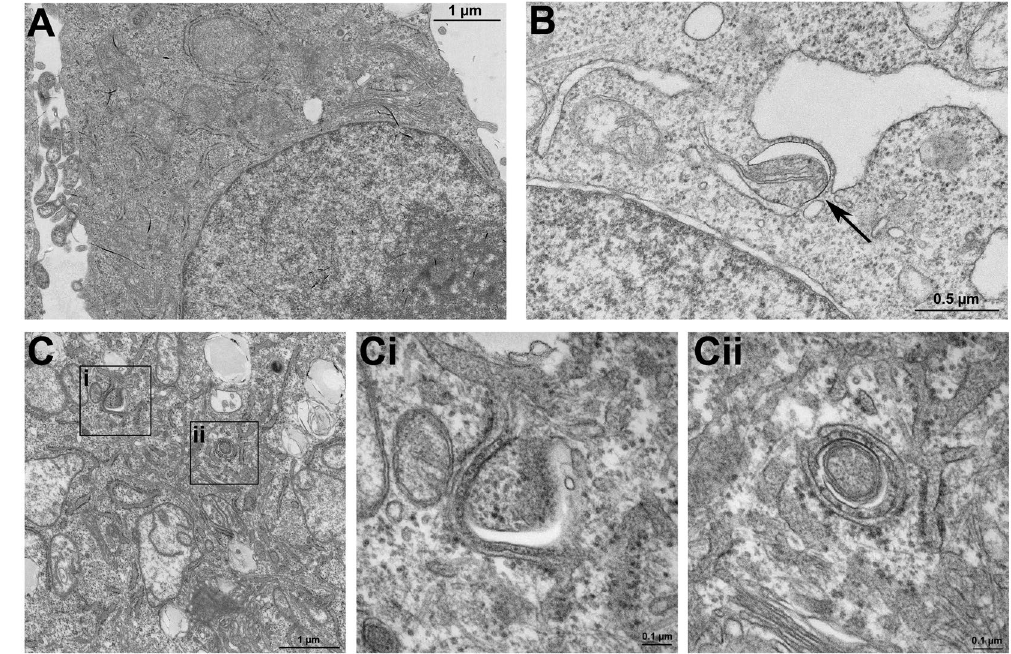
Figure 5. Autophagosome formation in KLF6 over-expressing HepG2 cells. Under a transmission electron microscope, the autophagosome formation was observed and imaged in HepG2 cells transfected with the empty vector (pcIneo) ( A ), in HepG2 cells transfected with pcIneo treated with 15 µ M rapamycin for 6 h to stimulate autophagosome formation ( B ) and in KLF6 -over-expressing HepG2 cells (pcIneo-KLF6) ( C ). Representative slides and blow-ups shown are shown of n = 2 independent cell culture